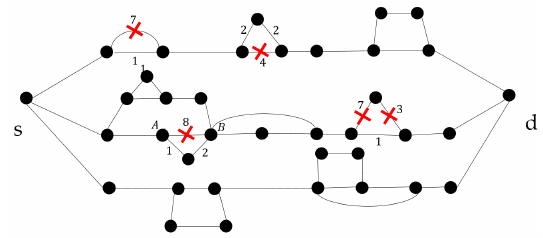
Figure 7. An example of pruning in the deterministic case.